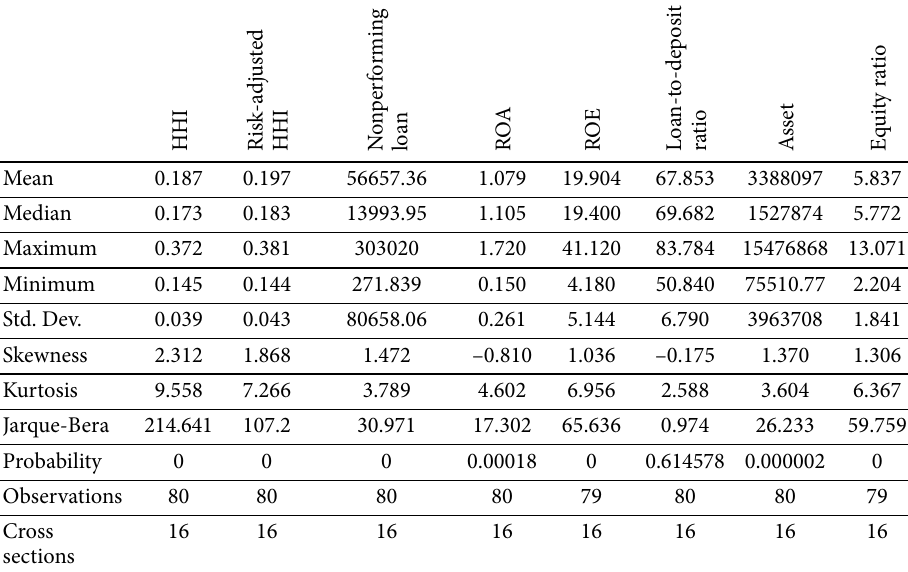
Table 5. Summary statistics of the